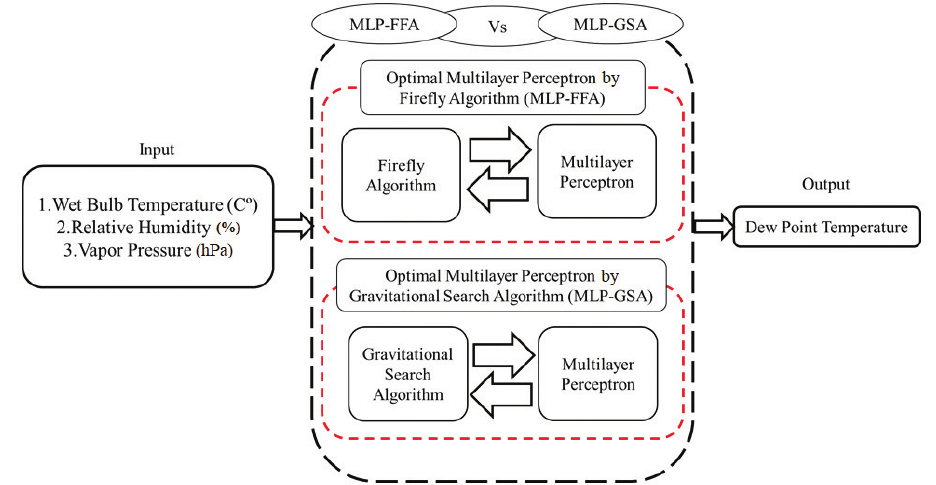
Figure 2. Schematic structure of the hybrid multilayer perceptron–firefly algorithm (MLP–FFA) and MLP–gravitational search algorithm (MLP–GSA) methods applied for dew point temperature